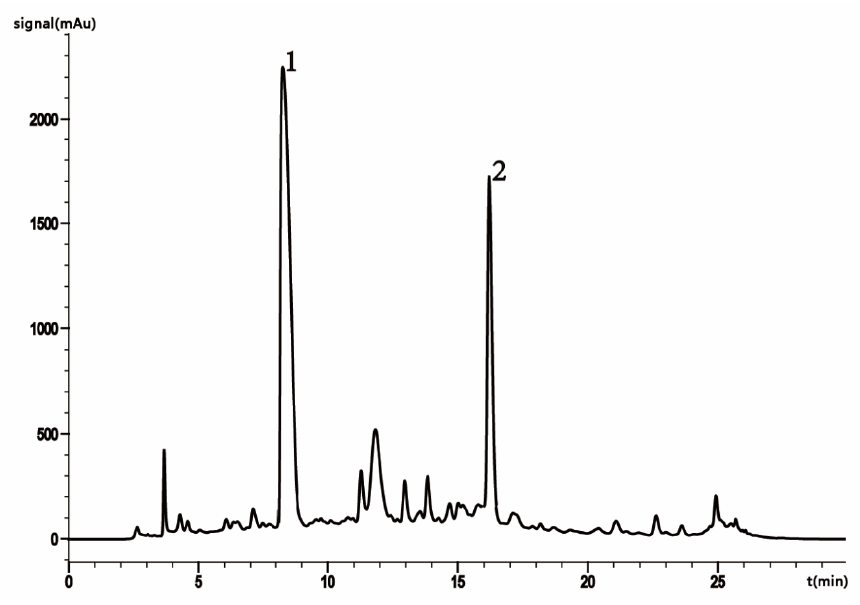
Figure 2. HPLC chromatogram of the extraction samples. 1: HSYA; 2: AHSYB.